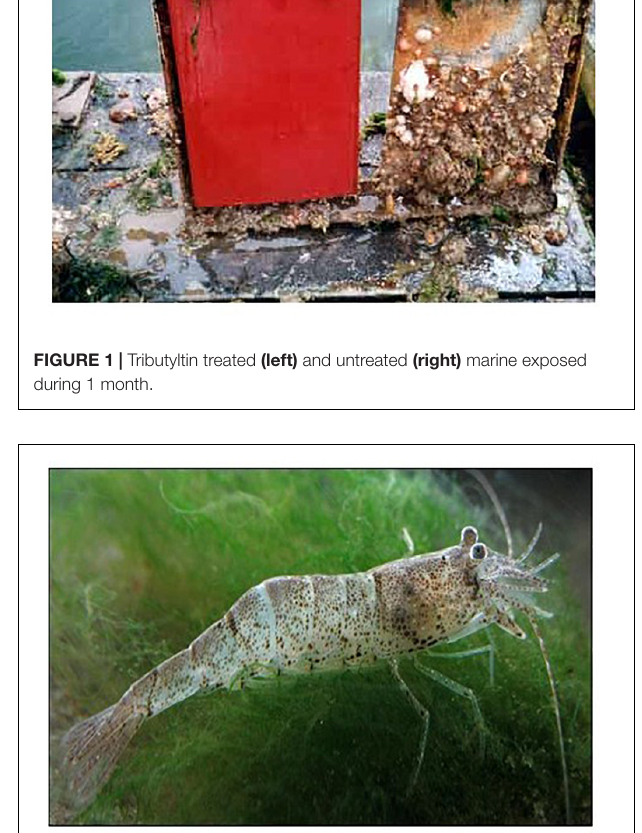
FIGURE 2 | Crangon crangon (brown shrimp; © 2008